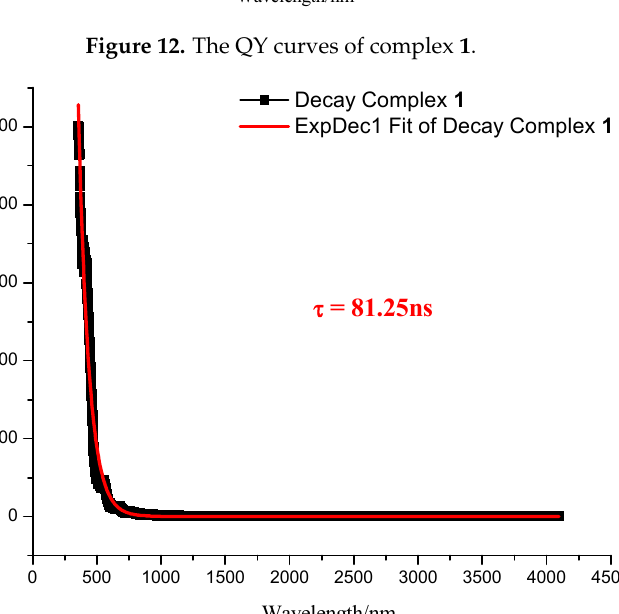
Figure 13. Luminescence decay curve for compound 1 (the black and red lines represent experimental data and fitting result, respectively).